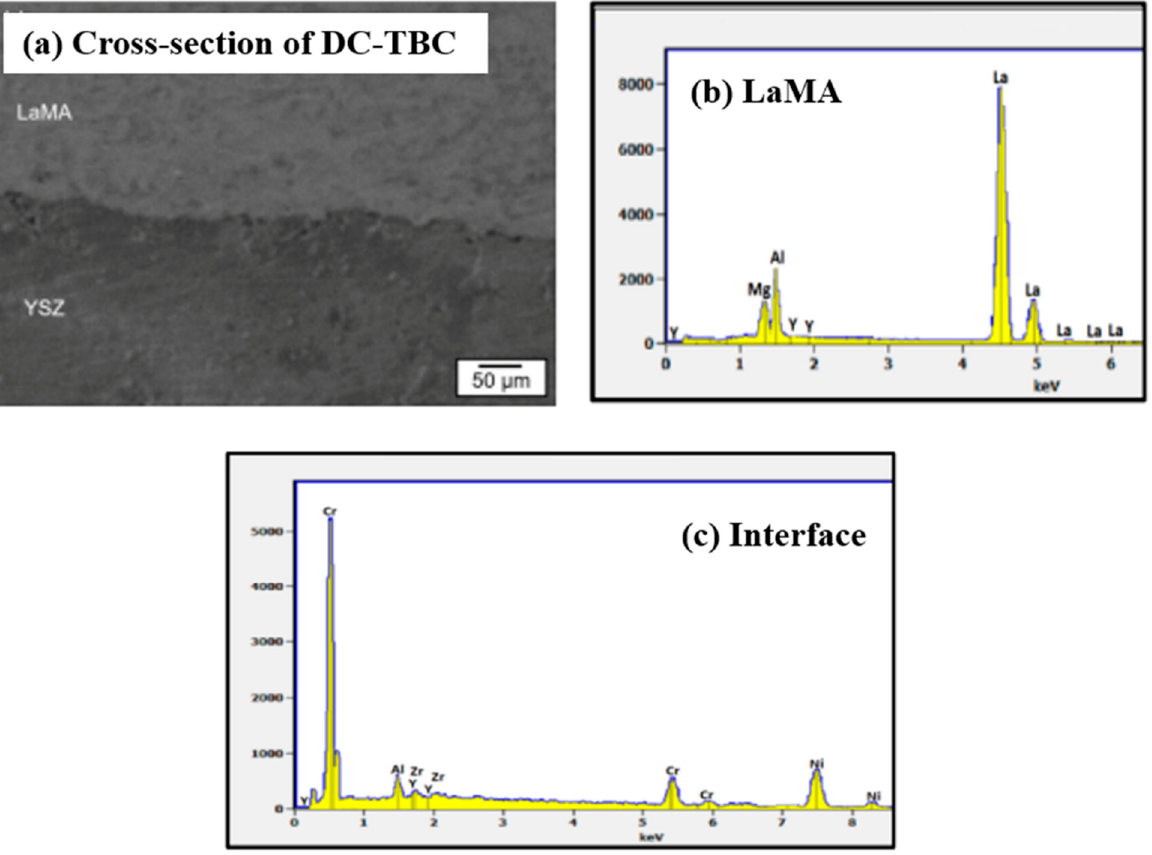
Figure 7. ( a ) SEM image of DC-TBC (cross-section). ( b ) EDS spectrum on LaMA. Peaks corresponding to La, Mg, Al and Y are present. ( c ) EDS spectrum of the YSZ/metallic bond coat interface. Peaks corresponding to Y, Zr, La, Al, Cr and Ni are present.